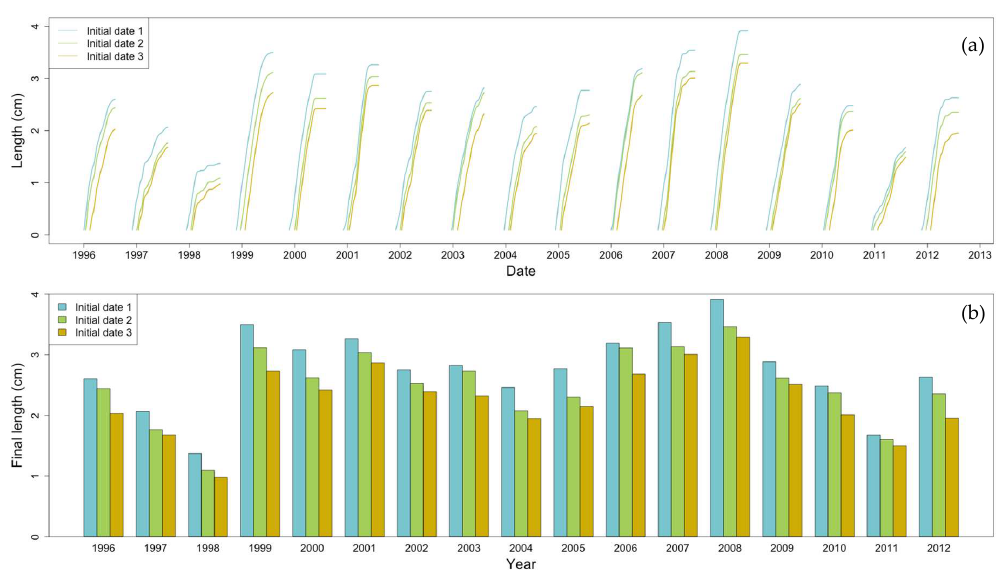
Figure 3. ( a ) Individual annual shell length trajectories simulated by a mussel Dynamic Energy Budget (DEB) model and ( b ) corresponding final length.